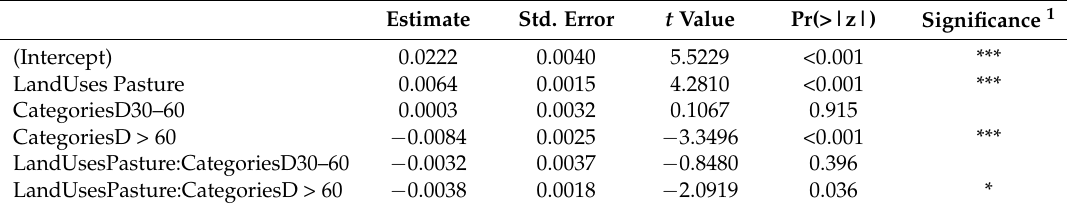
Table 2. Coefficients and level of significance obtained from generalized linear mixed effect model (GLMM) for soil organic carbon (SOC) as a function of land use, soil depth, and studies, where we considered pasture as the reference level of land use type. CategoriesD: Soil depth categories (0–30, 30–60 and >60 cm); LandUses: land use (forests vsersus pasture).